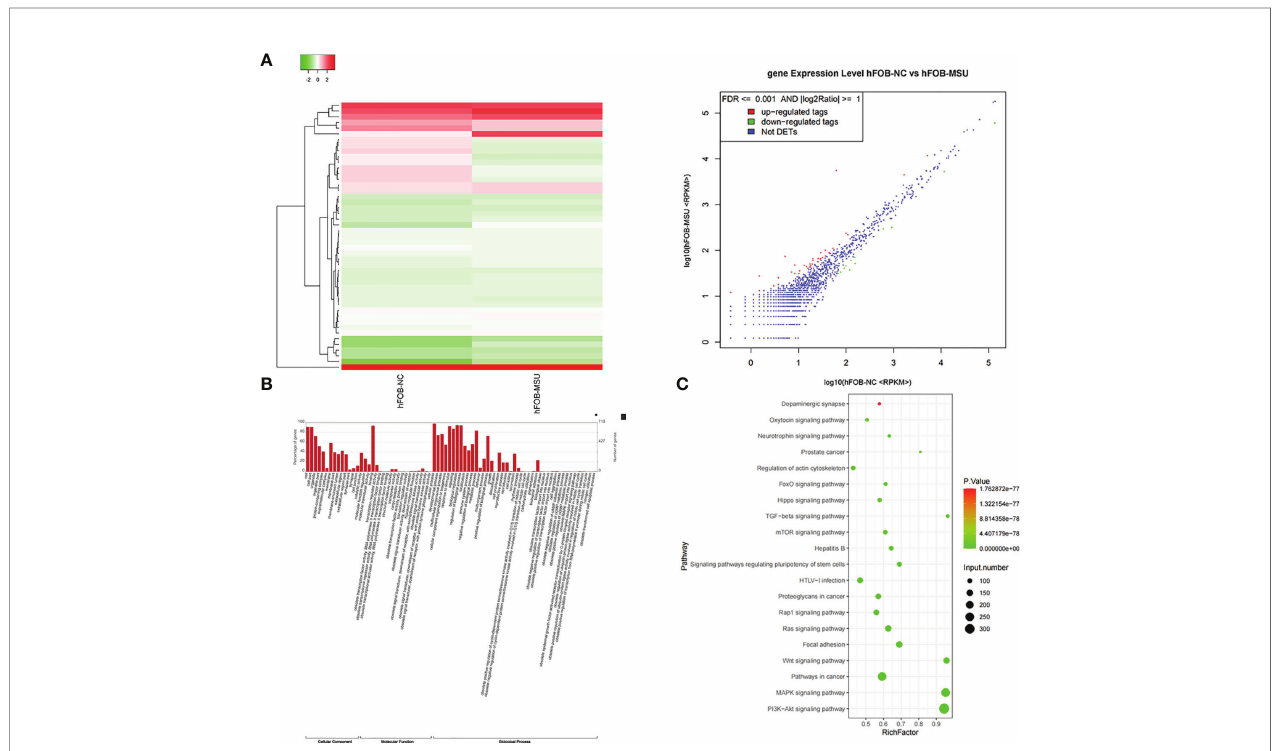
FIGURE 5 | Exosomes induce differential expression of miRNA in hFOB. (A) Changes in miRNA expression in hFOB are detected. High-throughput sequencing is performed, and analysis of miRNA-seq data is conducted in both groups. (B) The target genes of differentially expressed miRNAs are predicted by Gene Ontology (GO) analyses. (C) KEGG analysis of target genes is performed. miRNA is enriched in many typical osteogenic pathways, including TGF- b , MAPK, PI-3K and Wnt